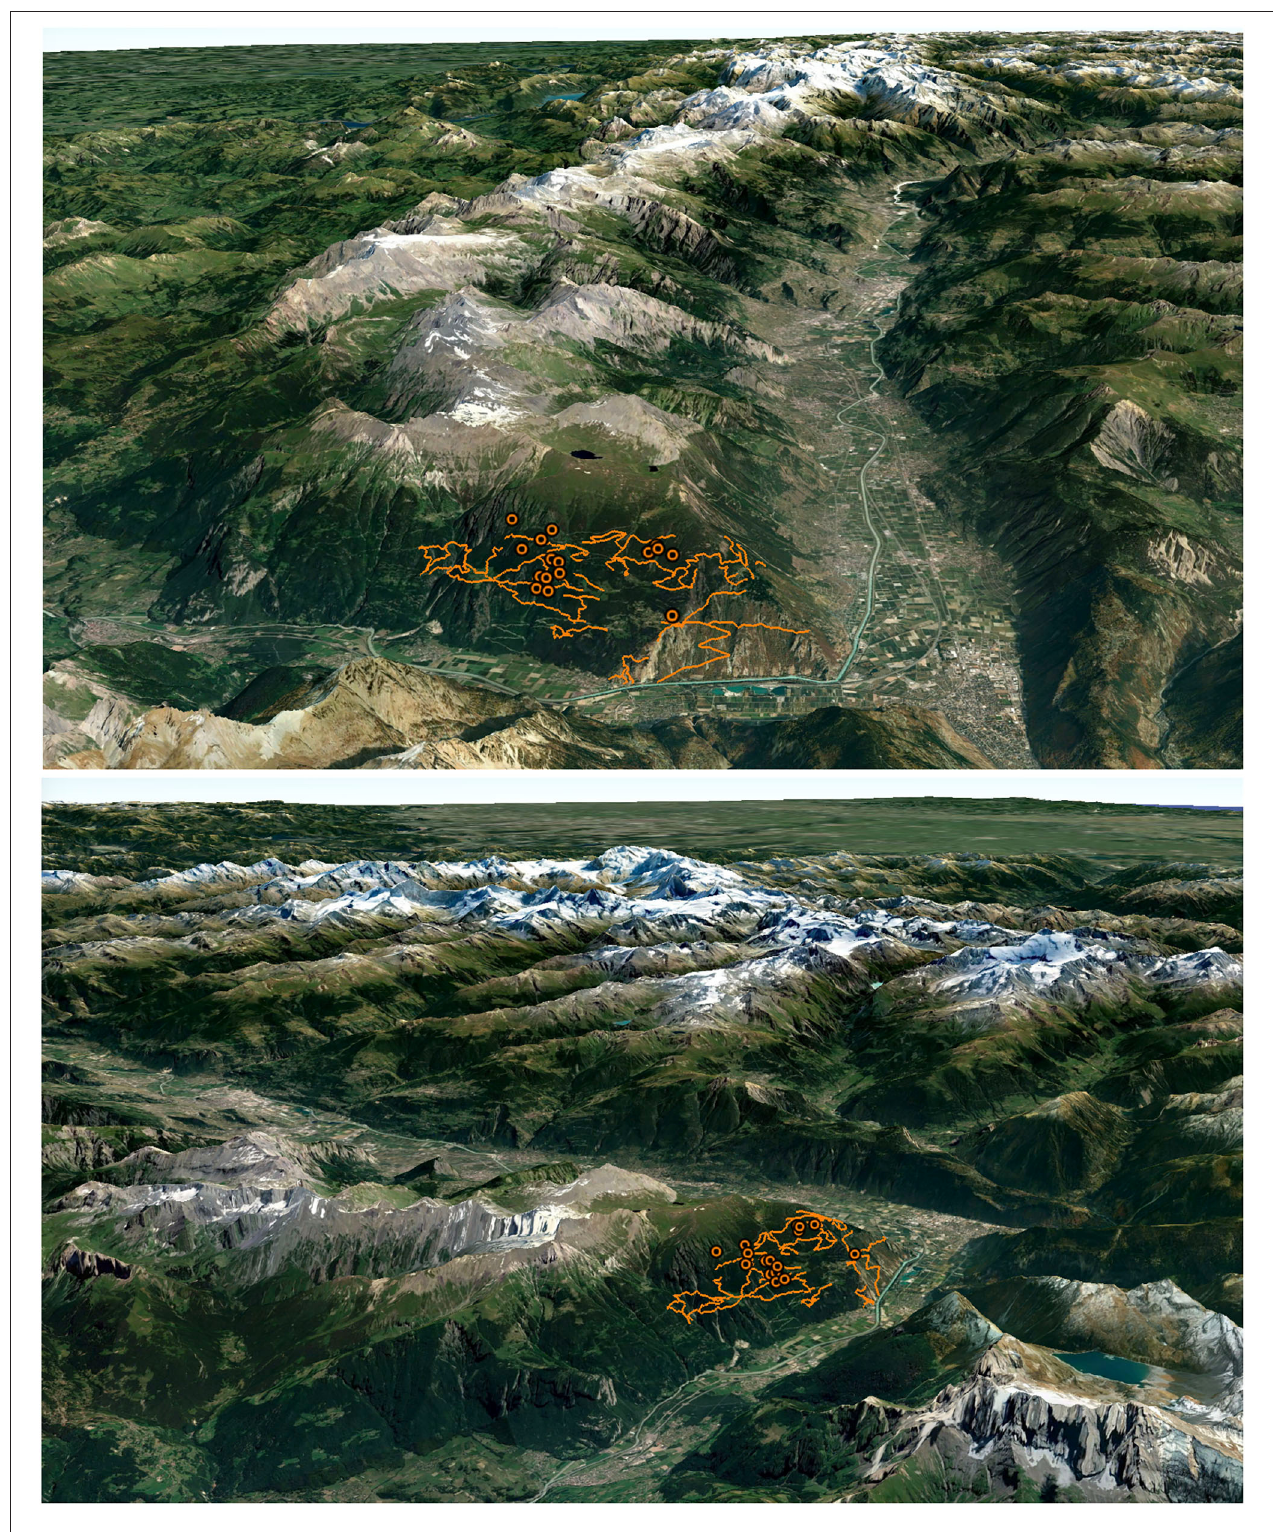
FIGURE 6 | The Google Earth TM views (upper projection from the southwest; lower projection from the northwest; compare to Figure 1 ) of the entrance corridor into Valais from the lynx-populated Prealps showing 39km of trails (orange lines) explored for neck-snare traps, with an indication of the 17 neck-snaring sites (orange dots) discovered (two neck-snare traps are so close that they appear as a simple dot). The forest belt and the barriers for dispersal shaped by high mountain chains are obvious.